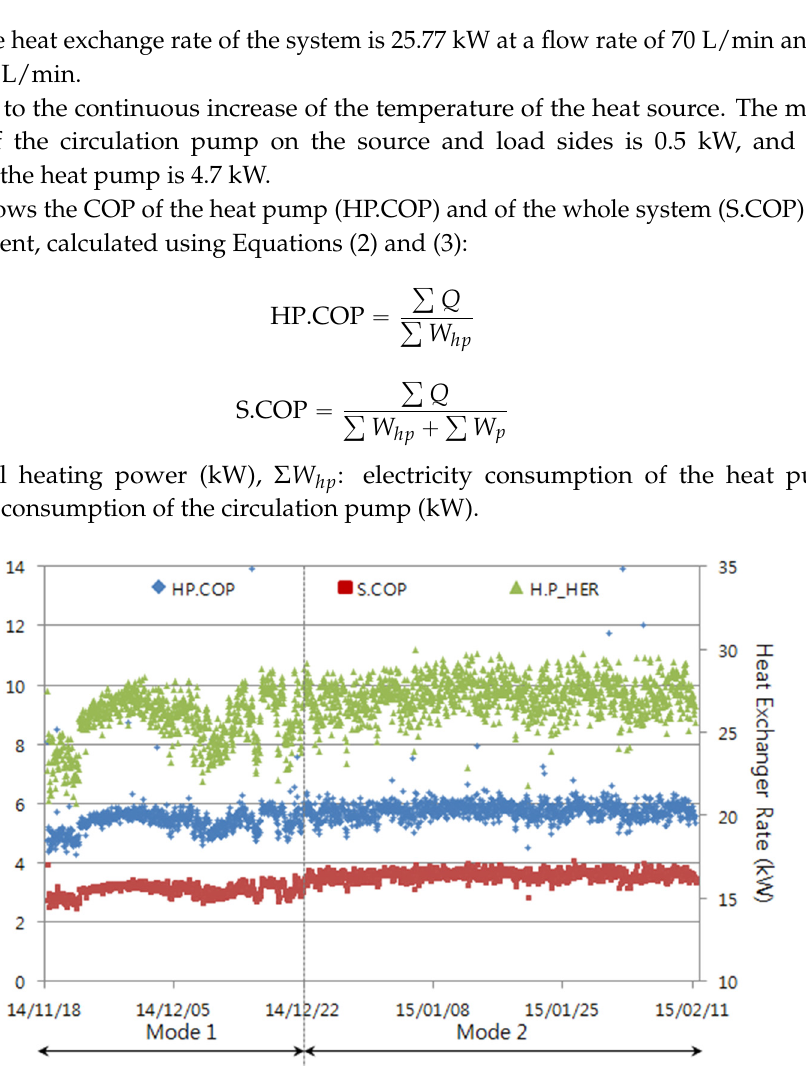
Figure 6. Heating performance of the GSHP: COP of the heat pump (HP.COP, blue diamonds) and of the whole system (S.COP, red squares), with thermal power exchanged (H.P_HER, green triangles).